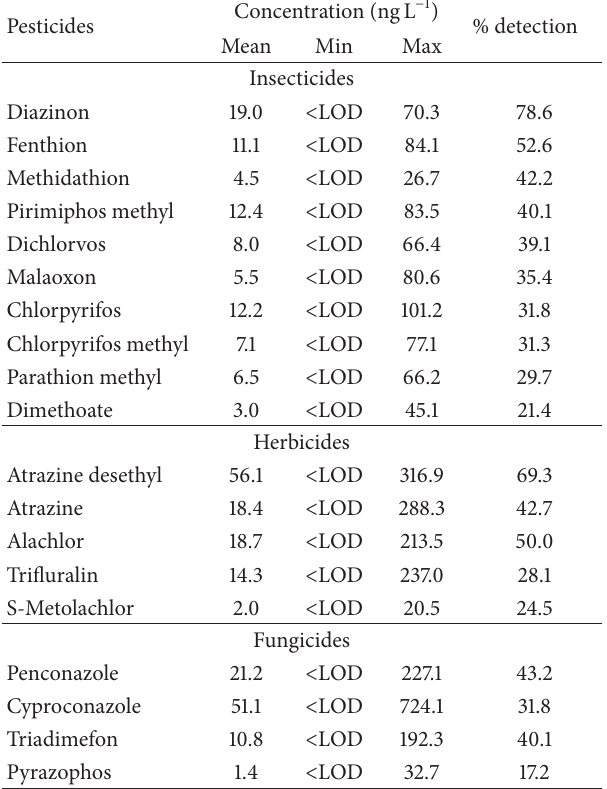
Table 1: Mean, minimum, and maximum concentrations (ngL − 1 ) and frequency of detection (%) for the nineteen most frequently detected pesticides and